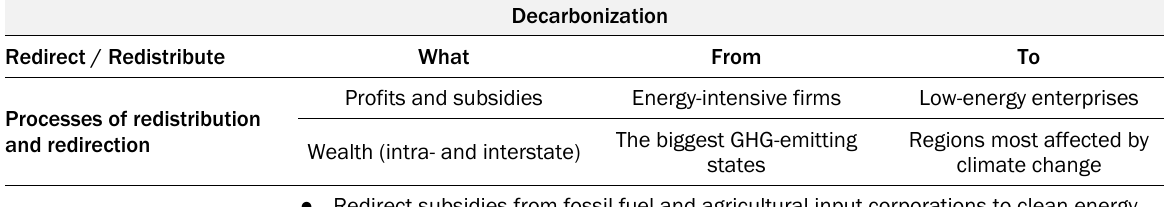
Table 2. Examples of Redistributive Policies Supporting